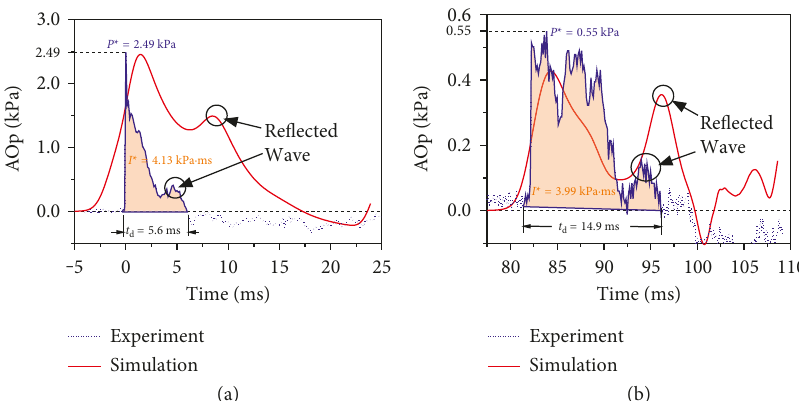
Figure 15: Time profiles of AOp and impulse: (a) Point A and (b) Point B.